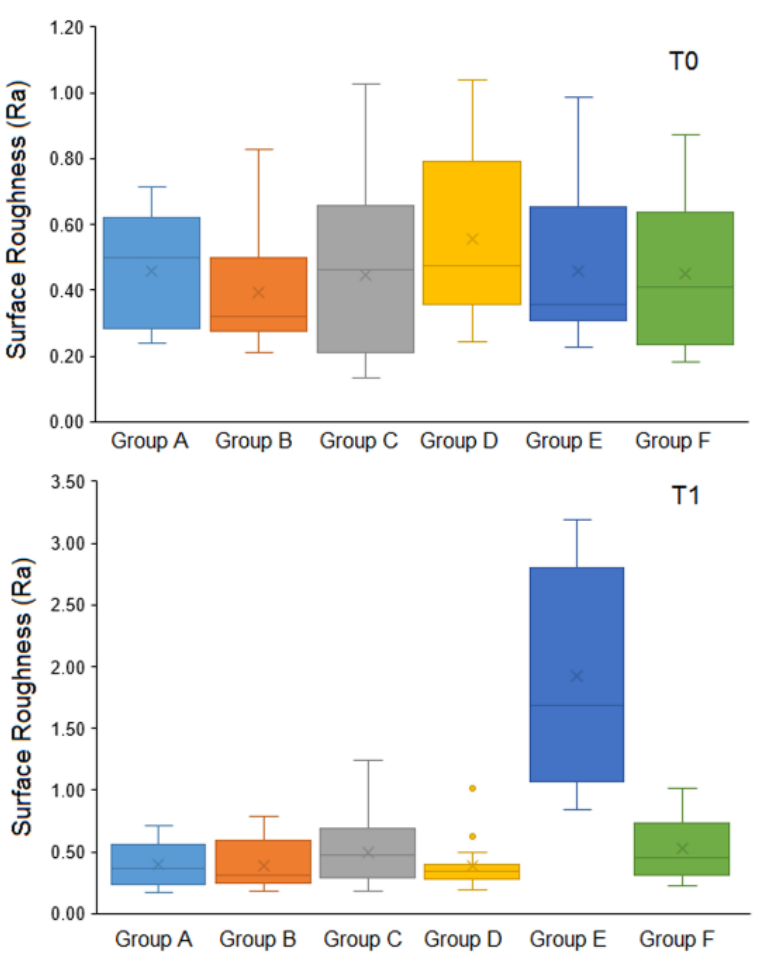
Figure 1. Box plots of surface roughness (Ra) of the study groups at different measurement intervals. Group A—Opalescence™ PF; Group B—distilled water; Group C—iWhite Dark Stains Toothpaste; Group D—24 K white charcoal teeth-whitening pen; Group E—0.